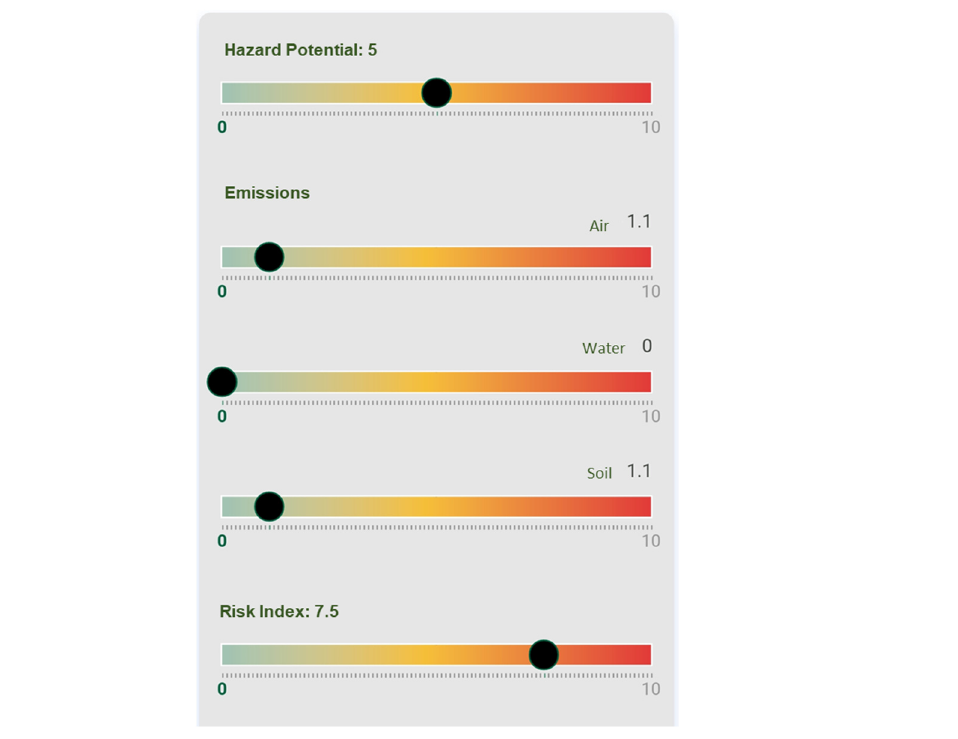
Figure 6. Excerpt from the report generated with the NanoSerpa v1.0 app for an accidental spillage of a dry mortar containing TiO 2 . These results apply only to the exposure area where the events studied have occurred. Table 6. Input data used for NanoSerpa v1.0 simulated